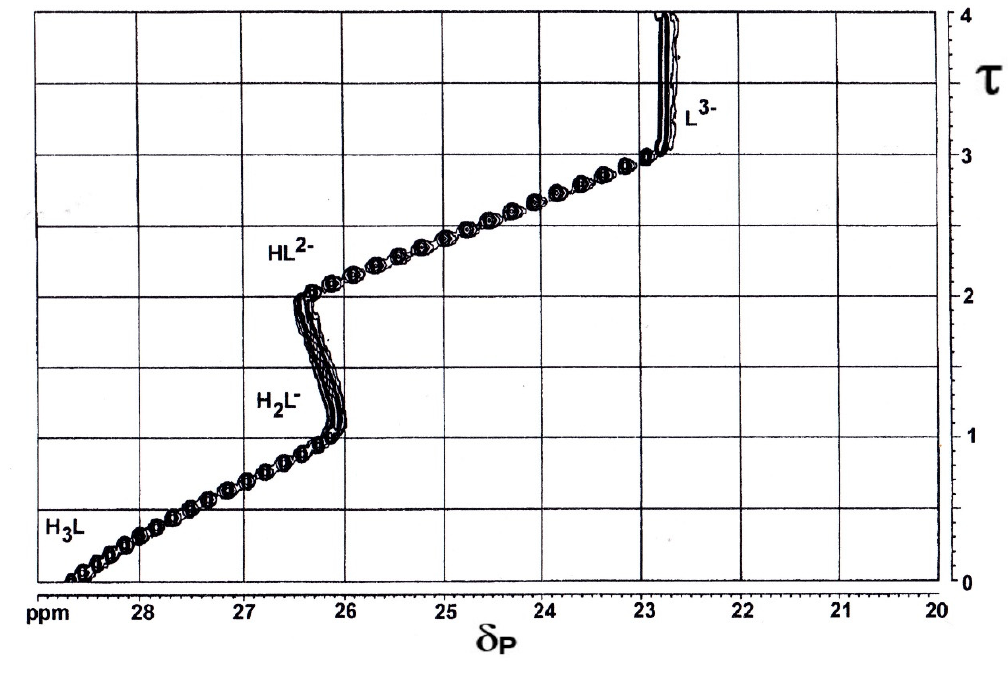
Figure 3. ( a ) 13 C{ 1 H}-NMR-controlled titration of 3-phosphonopropionic acid 7c vs. NaOH. Contour plot showing the range of the carboxylic carbon C1. For experimental data, see Table 10. X -axis: δ C [ppm]. Y -axis: degree of titration τ ; ( b ) 13 C{ 1 H}-NMR-controlled titration of 3-phosphonopropionic acid 7c vs. NaOH. Contour plot showing the range of the aliphatic carbons C2 and C3. For experimental data, see Table 10. X -axis: δ C [ppm]. Y -axis: degree of titration τ ; ( c ) 81 MHz 31 P{ 1 H}-NMR-controlled titration of 3-phosphonopropionic acid 7c vs. NaOH X -axis: δ P [ppm]. Y -axis: degree of titration τ . C Titrand : 0.010 mol/L of 7c . C Titrator : 0.10 mol/L TMAOH. Digital resolution: 0.6 Hz/point in x -axis. [51]. Table 12. Gradients ∆ i of specific chemical shifts δ P [ppm] of 7c . Experimental data: C Titrand :